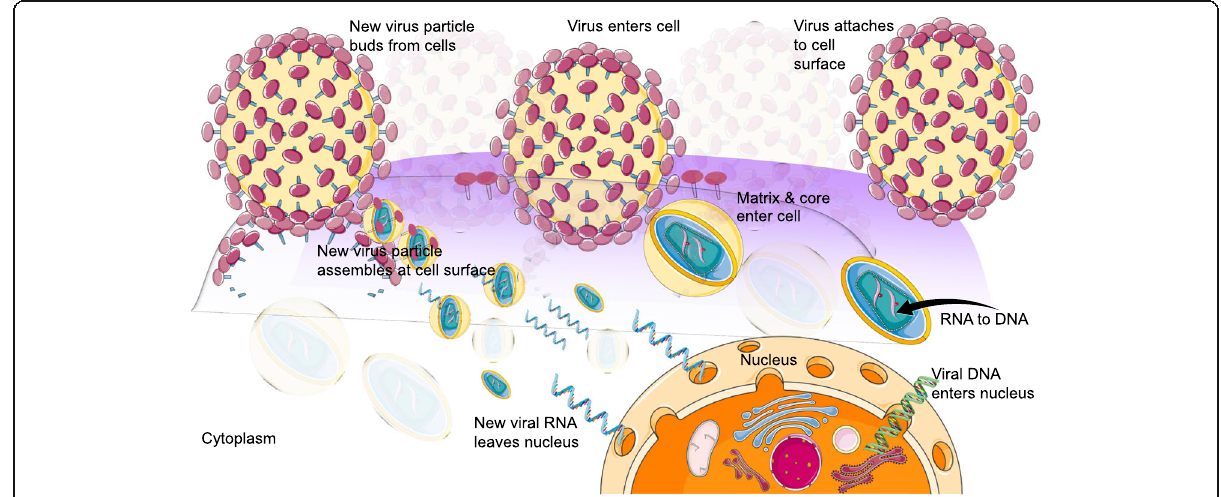
Fig. 2 HIV and host cell interaction. The general strategy of HIV multiplication is shown